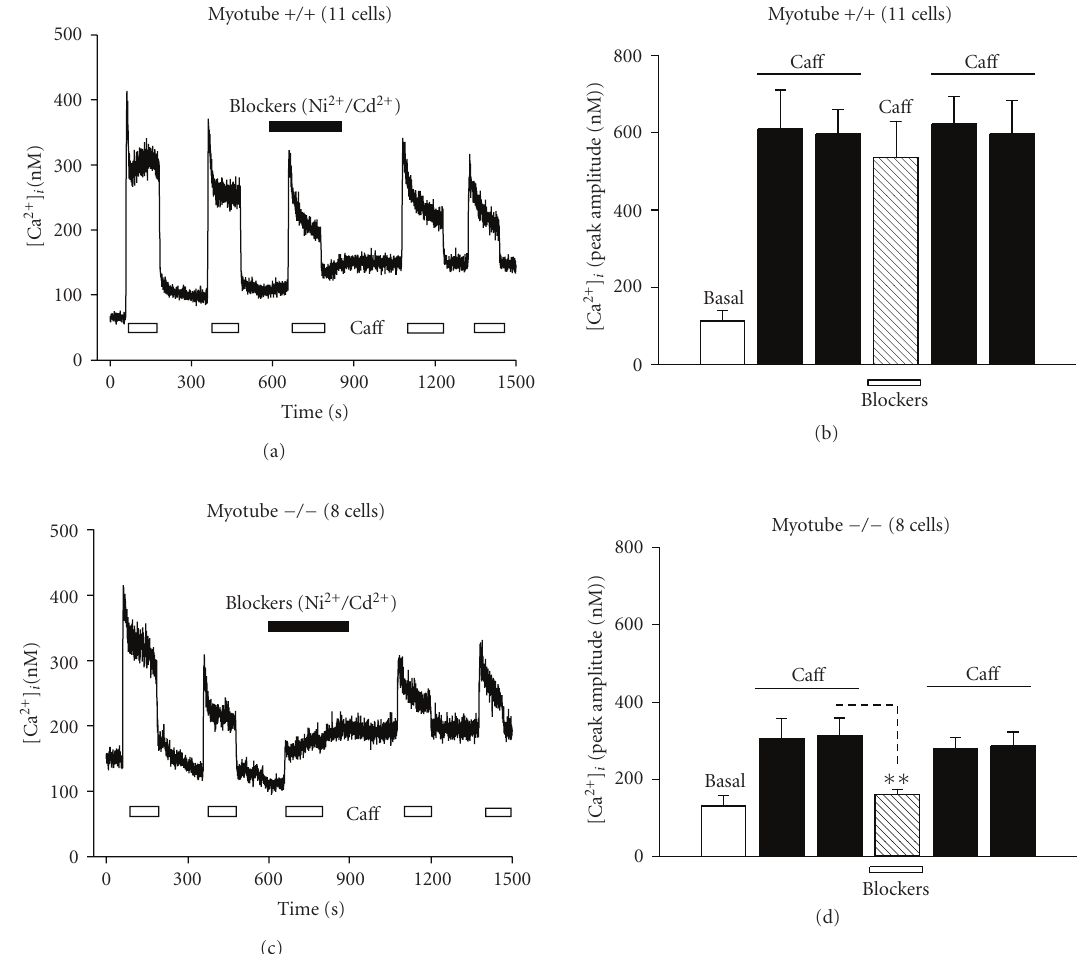
Figure 6: E ff ect of ca ff eine on [Ca 2+ ] i in isolated myotubes in the presence of Ca 2+ channel blockers (Ni 2+ /Cd 2+ ). Representative traces show the typical time course of the response to 20 mM ca ff eine observed in (a) wild type (+/+) myotube; (c) calpain 3-deficient ( − / − ) myotube, each treated with Ni 2+ /Cd 2+ . The duration of exposure to ca ff eine (open bars), or 50 μ M Ni 2+ /100 μ M Cd 2+ (closed bars) is represented. Bar diagrams (b) and (d) summarize the peak amplitude of the [Ca 2+ ] i response of myotubes to ca ff eine and CPA. The responses from the wild type myotubes (+/+; b) and calpain 3-deficient myotubes ( − / − ; d), are shown. Fifty μ M Ni 2+ /100 μ M Cd 2+ was added to the extracellular medium prior to the second application. The number of cells tested is given in